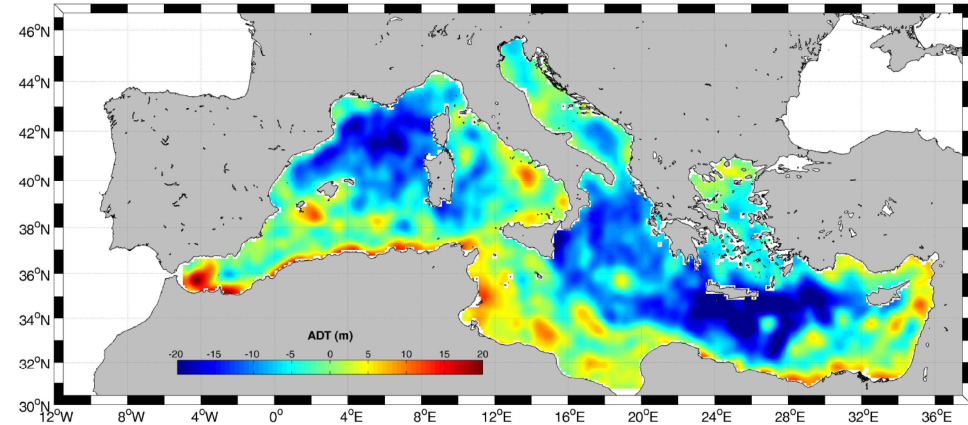
Figure 2c 4 Figure 2c. Monthly absolute dynamic topography (ADT) map of the Mediterranean Sea for April 2011.